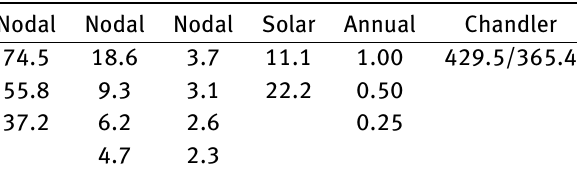
Table 2: Forced periodicities as part of the harmonic model used in this study. Periods are in years. Each period has a Sine and Cosine component. Nodal Nodal Nodal